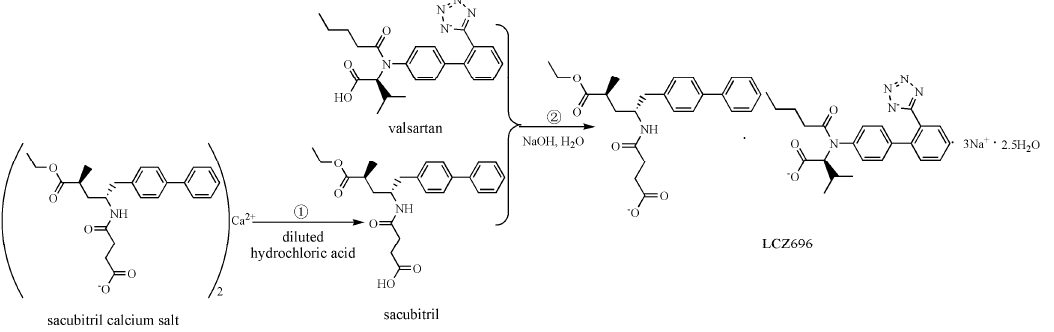
Figure 3. Synthetic route of LCZ696.